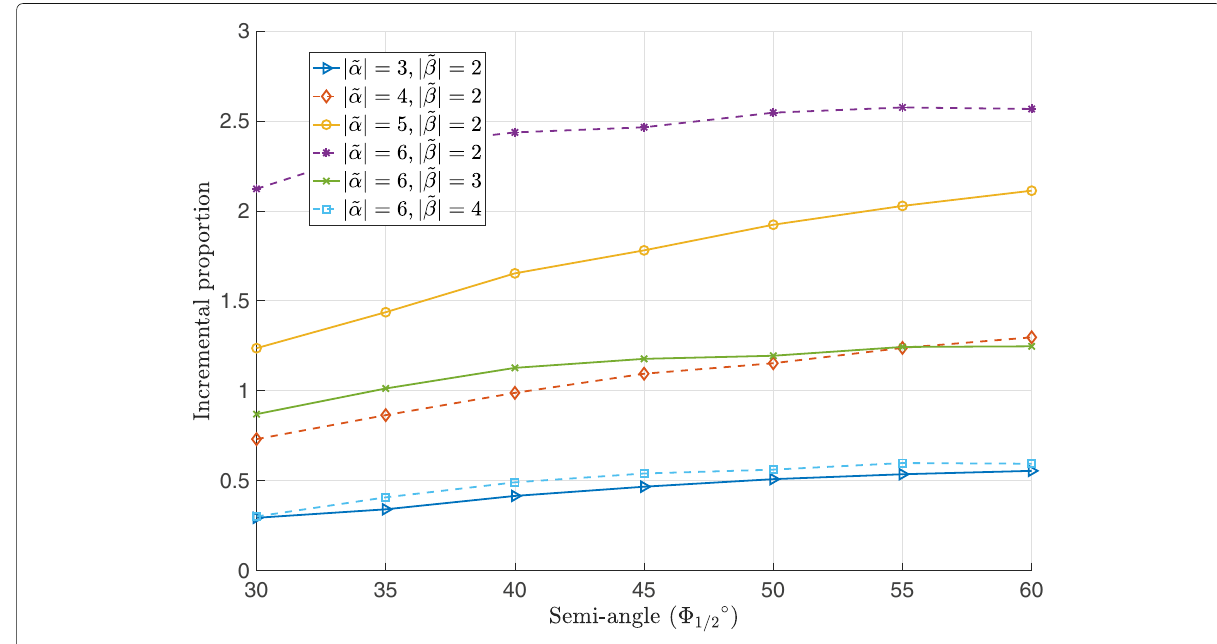
Fig. 7 Incremental proportion of VPPA with different semi-angles